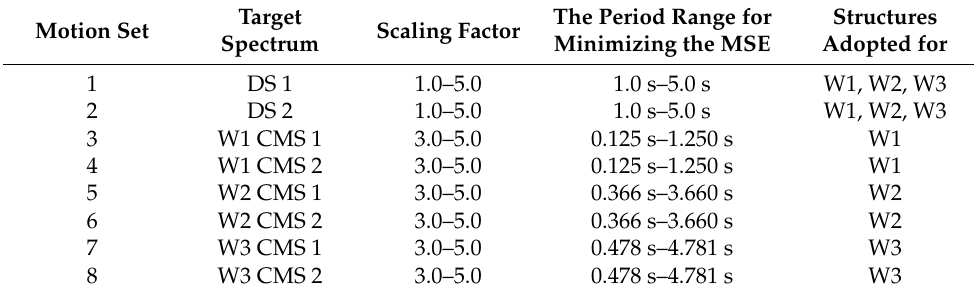
Table 4. IGMs scaling criteria.